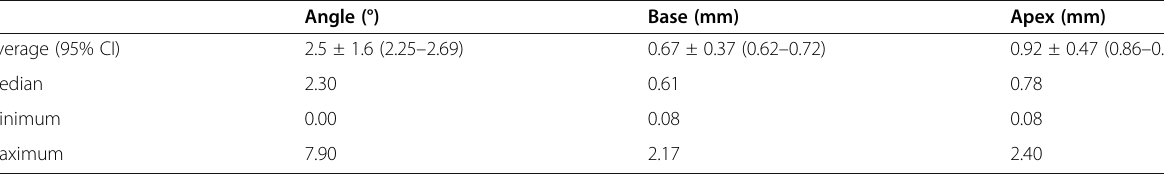
Table 2 Implant